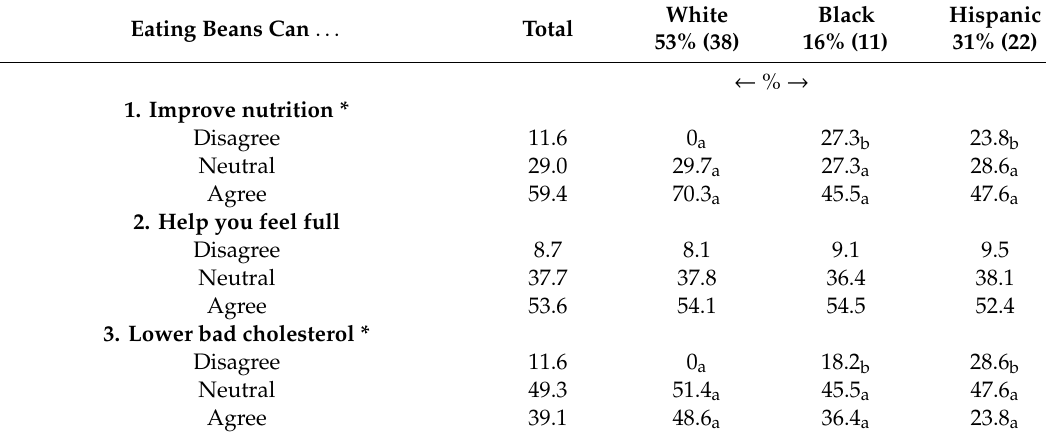
Table 3. Bean health benefit knowledge among Arizona men utilizing assistance programs by race / ethnicity category (percentage; N = 71). Eating Beans Can